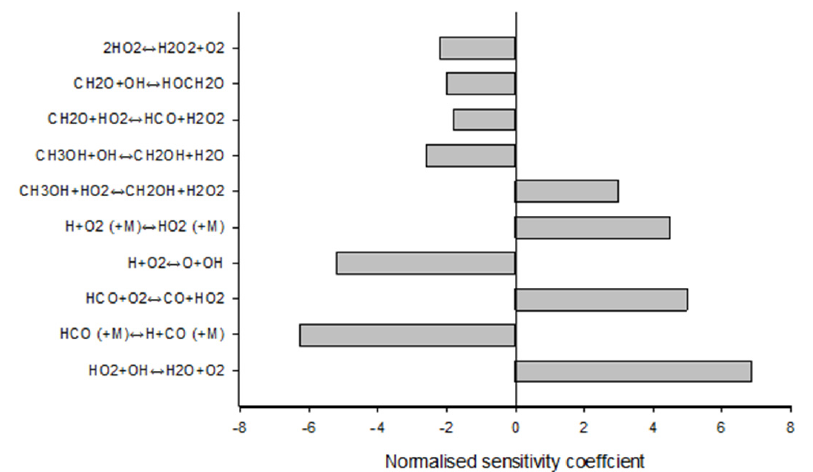
Figure 4. Sensitivity analysis for the laminar burning velocity of the stoichiometric methanol-air mixture at atmospheric pressure and the initial temperature (310 K).